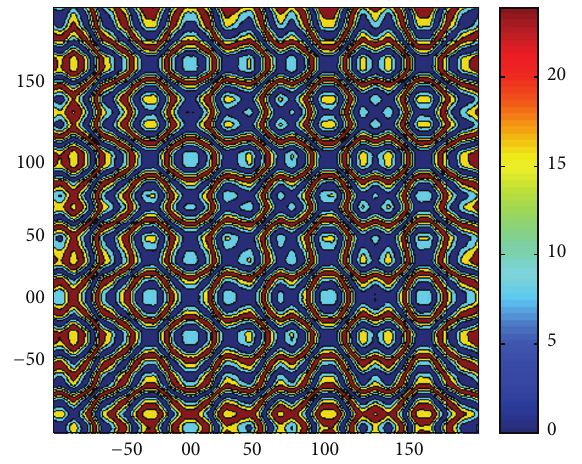
Figure 2: Example of a recurrence plot.